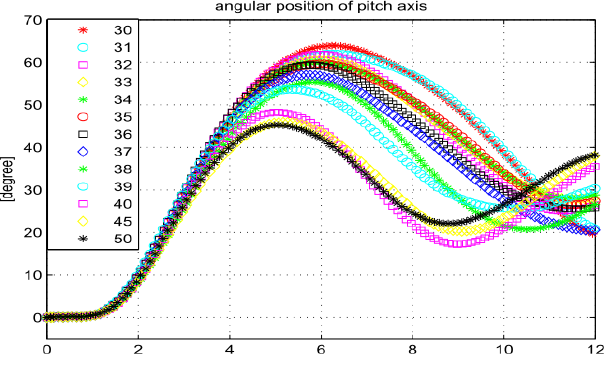
Fig. 8. Comparison of overshoot in pitch axis for different pole values of the lead